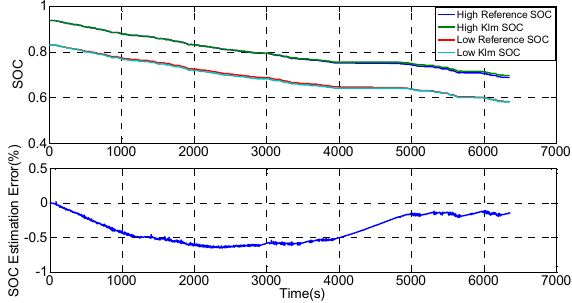
Figure 9. Battery cell SOC estimation and lowest SOC estimation error.